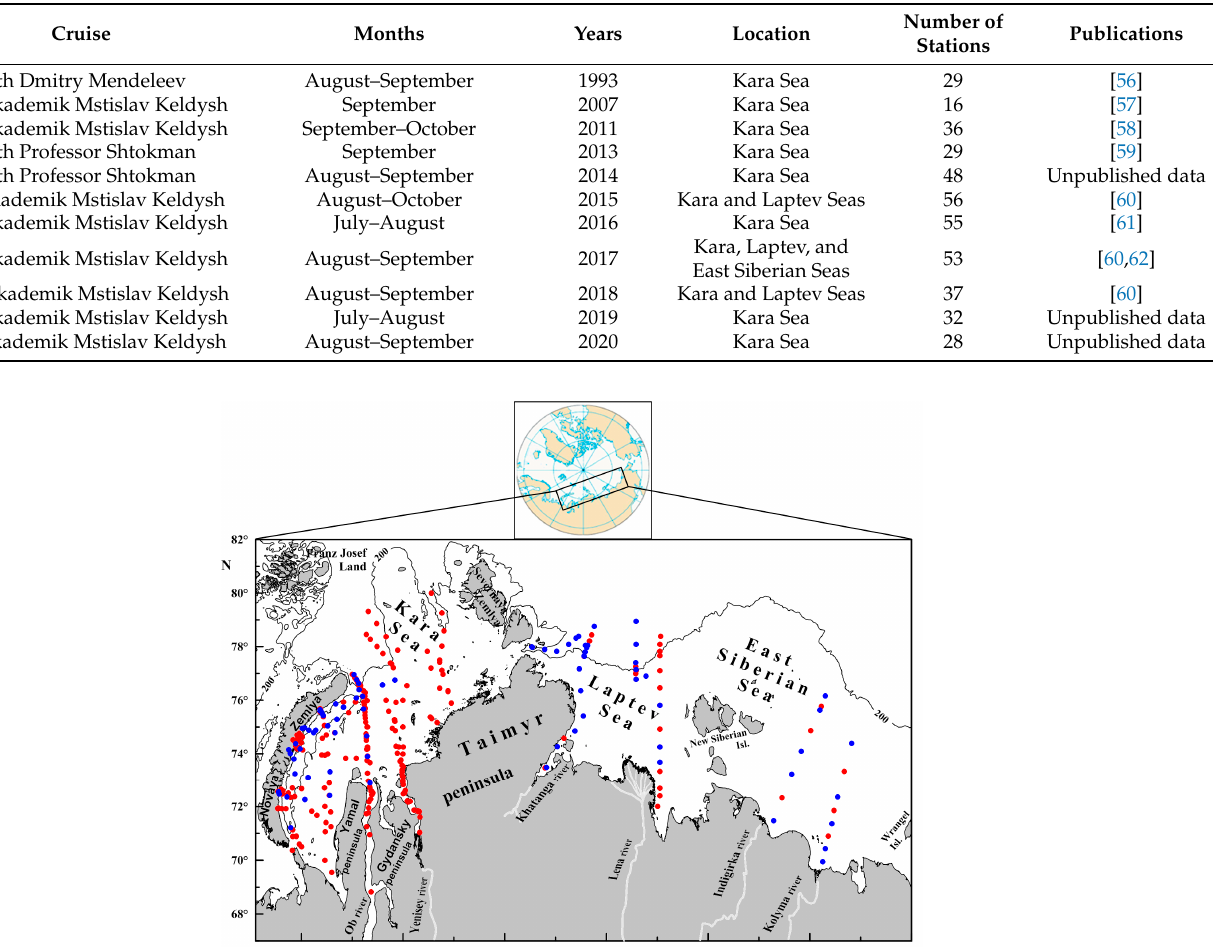
Table 1. Sources for primary production and chlorophyll a measurements included in the dataset for analysis of the variability in the optimal assimilation number, its links with environmental factors, and model development and verification.